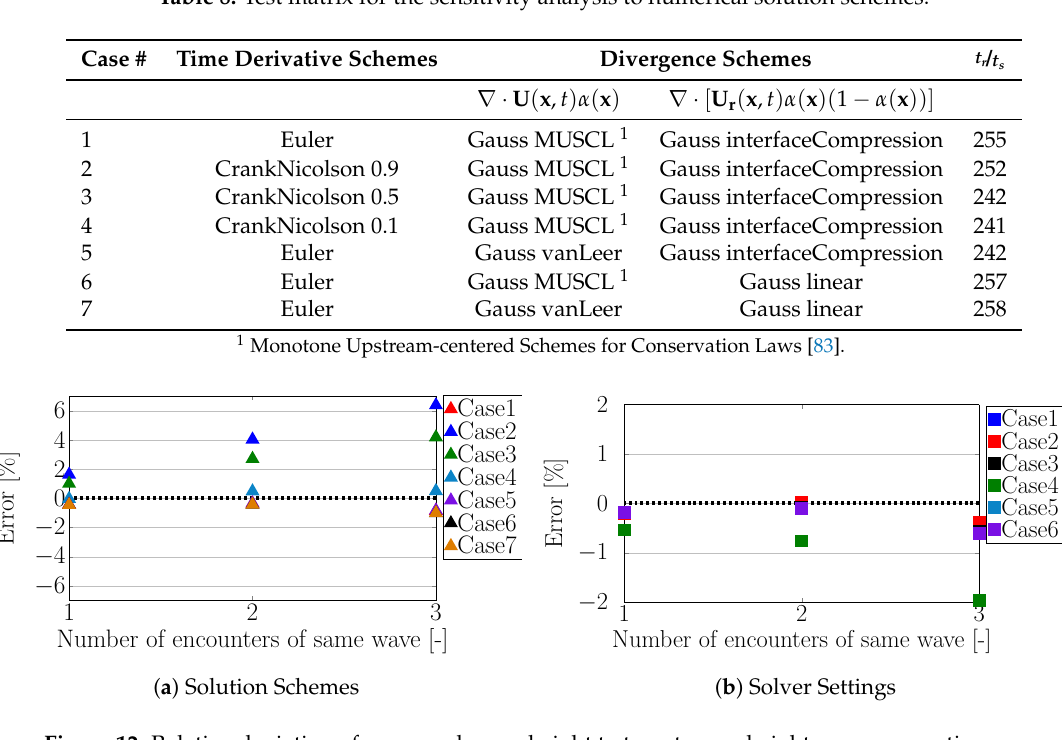
Figure 12. Relative deviation of measured wave height to target wave height over consecutive wave periods. Results are extracted using a single wave probe, i.e., OFWP.